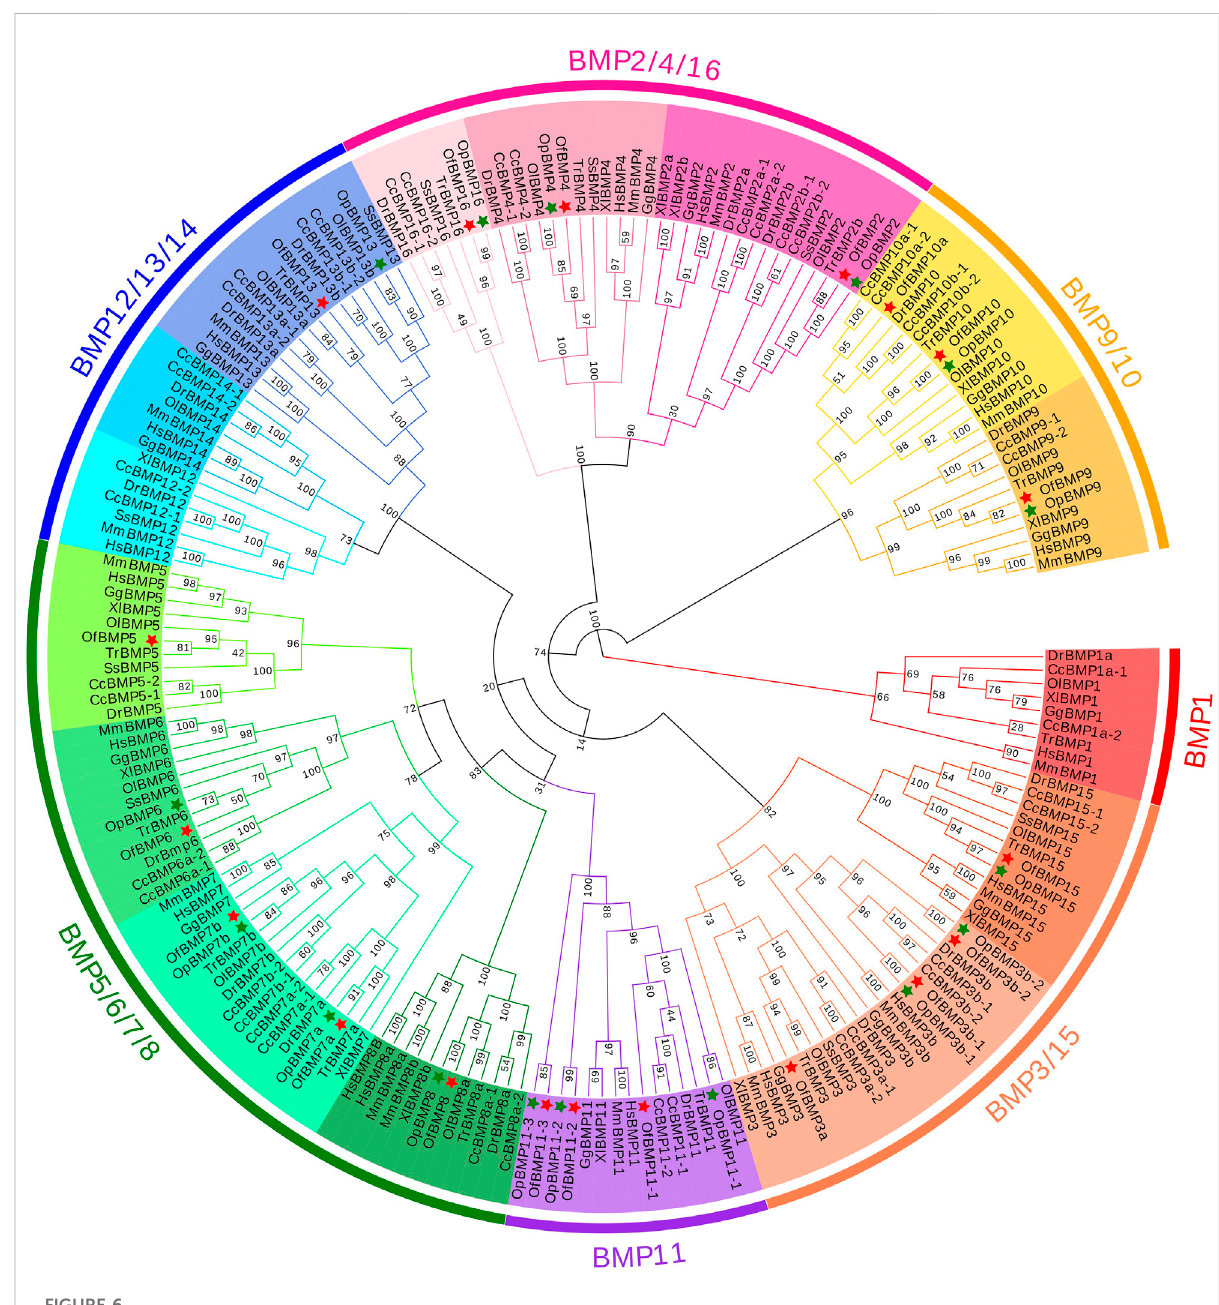
FIGURE 6 Phylogenetic tree of BMP gene family members in 11